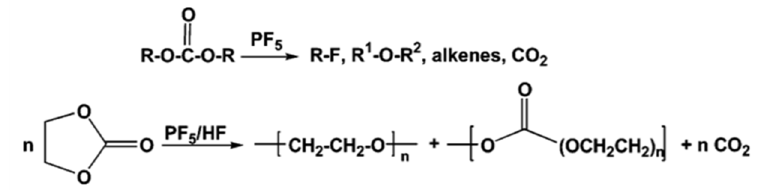
Figure 2. Carbonates decomposition by PF 5 [37].